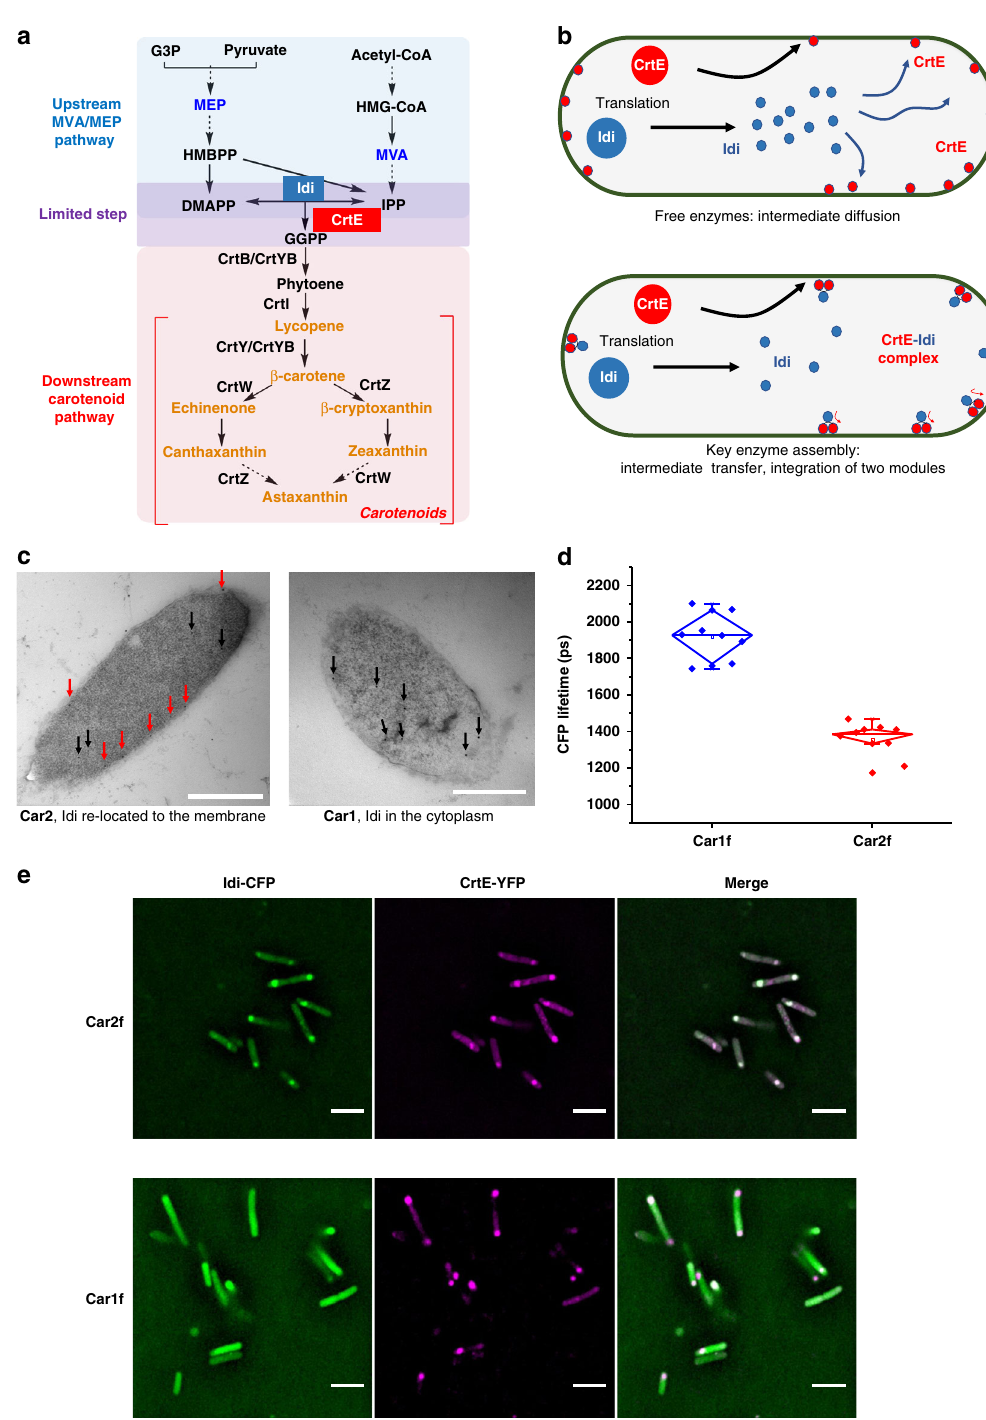
Fig. 2 Assembly of the limiting enzymes in carotenoid biosynthesis in the bacterium cells. a The Idi and CrtE enzymes represent the limiting step between the two pathways. b Physical association of Idi and CrtE changes the transfer of C5 precursors. Red fi lled circle: CrtE; blue fi lled circle: Idi; green circle: E. coli cells. c The RIAD – RIDD peptide interaction induces redistribution of Idi-speci fi c immunogold particles from the cytosol to the plasma membrane. Red arrows: Idi on the plasma membrane; black arrows: Idi in the cytosol. Scale bars: 500 nm. d FRET between Idi-CFP and CrtE-YFP measured by fl uorescence lifetime imaging microscopy (FLIM). The cells were excited at 810 nm in a two-photon microscope and the fl uorescent signals were collected at 481 nm. Error bars indicate the standard deviations of ten replicates. e Co-localization of assembled Idi-CFP and CrtE-YFP under the fl uorescent microscopy. Scale bars: 2 μ m. Source data are provided as a Source Data fi